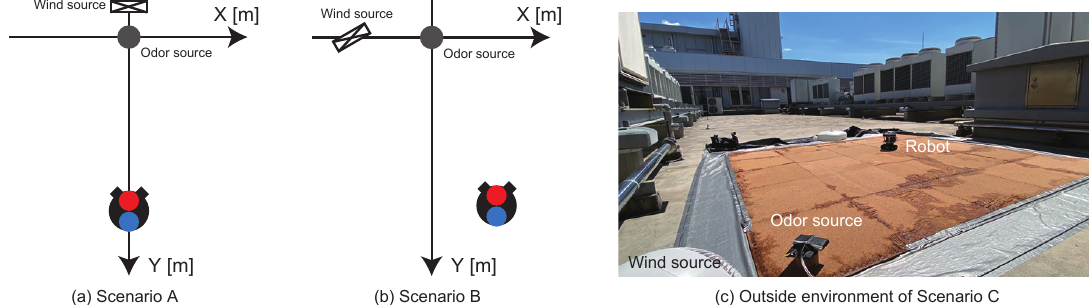
Figure 5. Schematic diagram of the experimental field for each